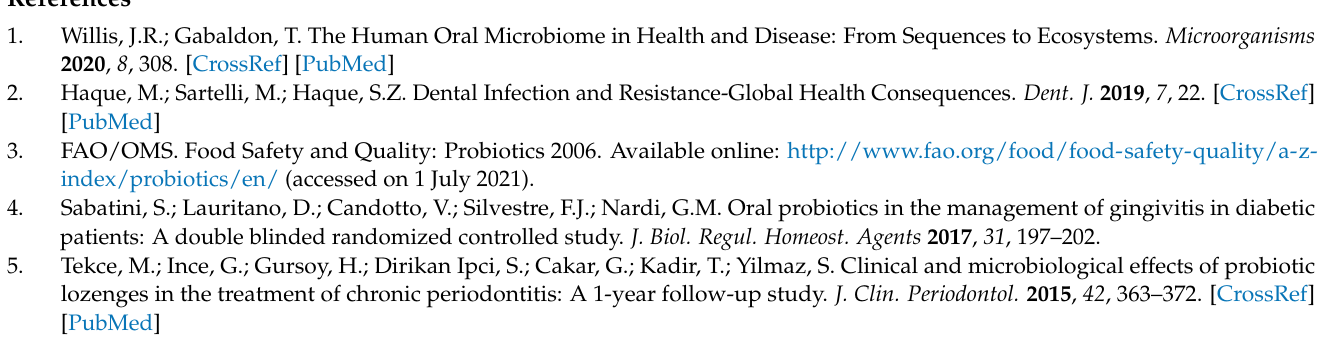
Analysis (PRISMA) flow diagram, Table S1: PRISMA checklist, Table S2: PICOS criteria, Table S3: Characteristics of clinical trials of probiotics in the oral ecosystem, Table S4: Characteristics of clinical trials of probiotics in gingivitis and gingival health, Table S5: Characteristics of clinical trials of probiotics in periodontal diseases, Table S6: Characteristics of clinical trials of probiotics in peri-implantitis, Table S7: Characteristics of clinical trials of probiotics in cariology, Table S8: Characteristics of clinical trials of probiotics in orthodontics, Table S9: Characteristics of clinical trials of probiotics in halitosis, Table S10: Characteristics of clinical trials of probiotics in oral wound healing and treatment of oral mucositis related to cancer